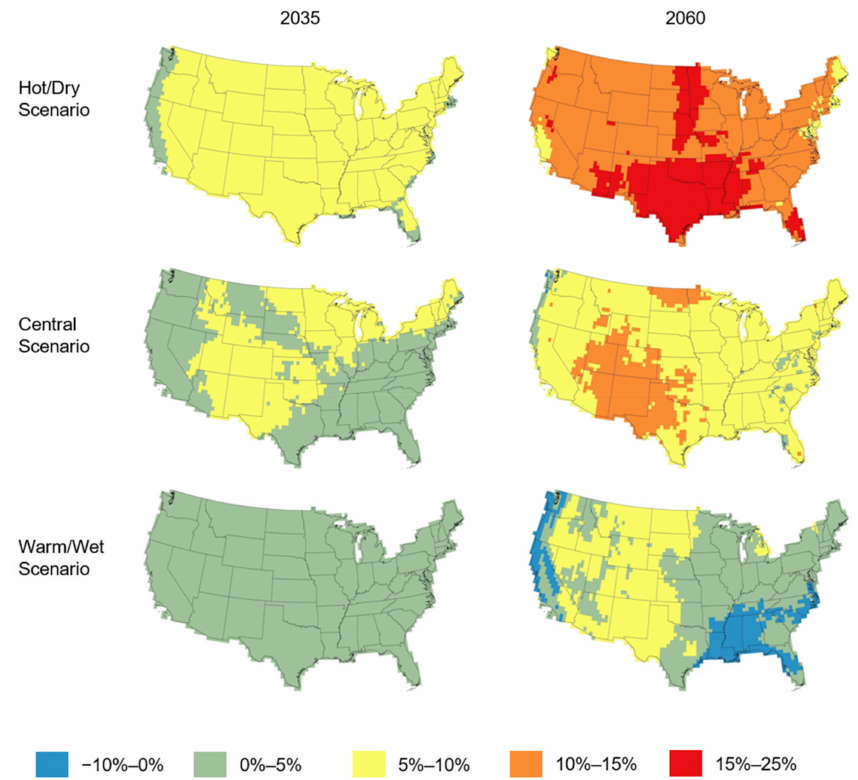
Figure 4. Projected changes in annual water system energy use due to temperature and precipitation.